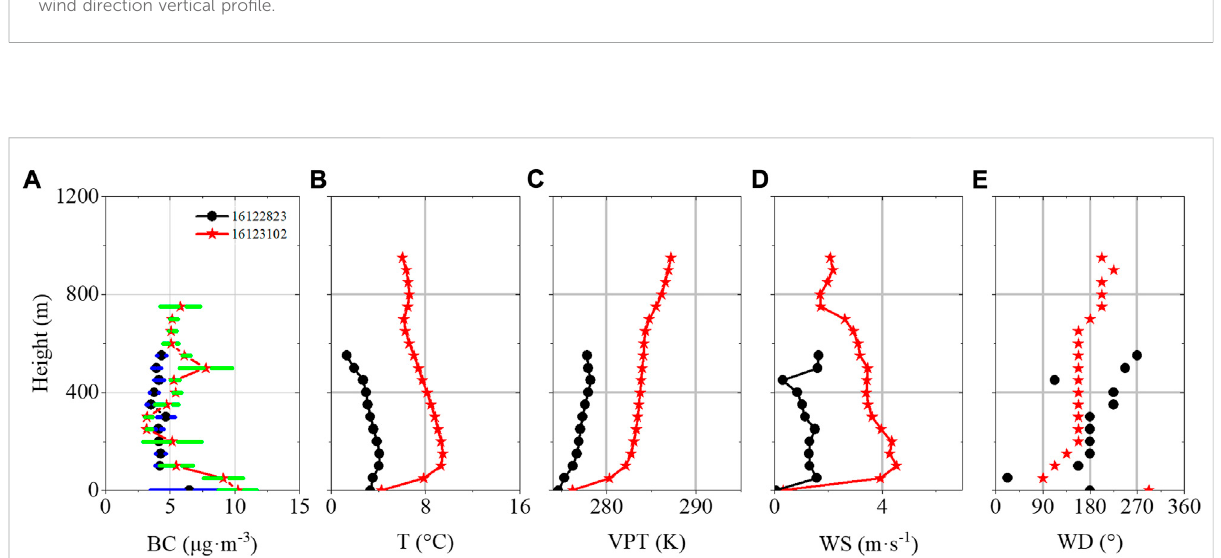
FIGURE 6 Thermally controlled stable boundary BC, T, VPT, WS and WD contours. The black line indicates the contours of each element at 2016122823 and thered lineindicatesthecontours ofeach element at2016122302.Green and bluelines areBC error bars. (A) black carbon